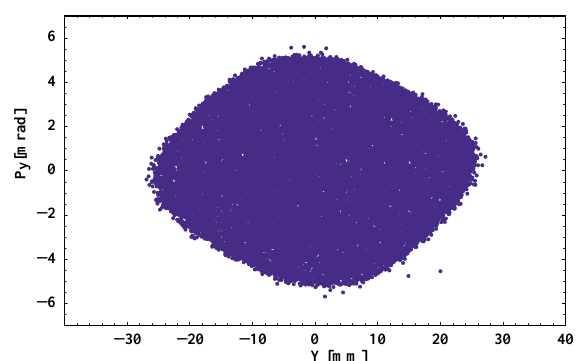
FIG. 17. (Color) Y - P y phase-space plot at 375 turns for (cid:2) (cid:1) (cid:1) 5.74, 5.71 (cid:2) . (cid:1) n x , n y